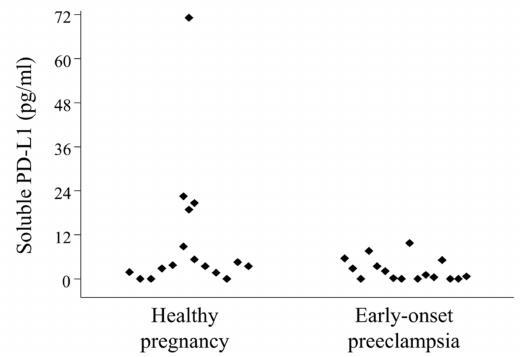
Figure 5. Circulating serum-soluble programmed death-ligand 1 (sPD-L1) levels in 3rd-trimester healthy pregnant women and in women with early-onset preeclampsia. Serum sPD-L1 levels in 16 healthy pregnant women and in 16 women with early-onset preeclampsia. Differences were considered statistically significant for p -values ≤